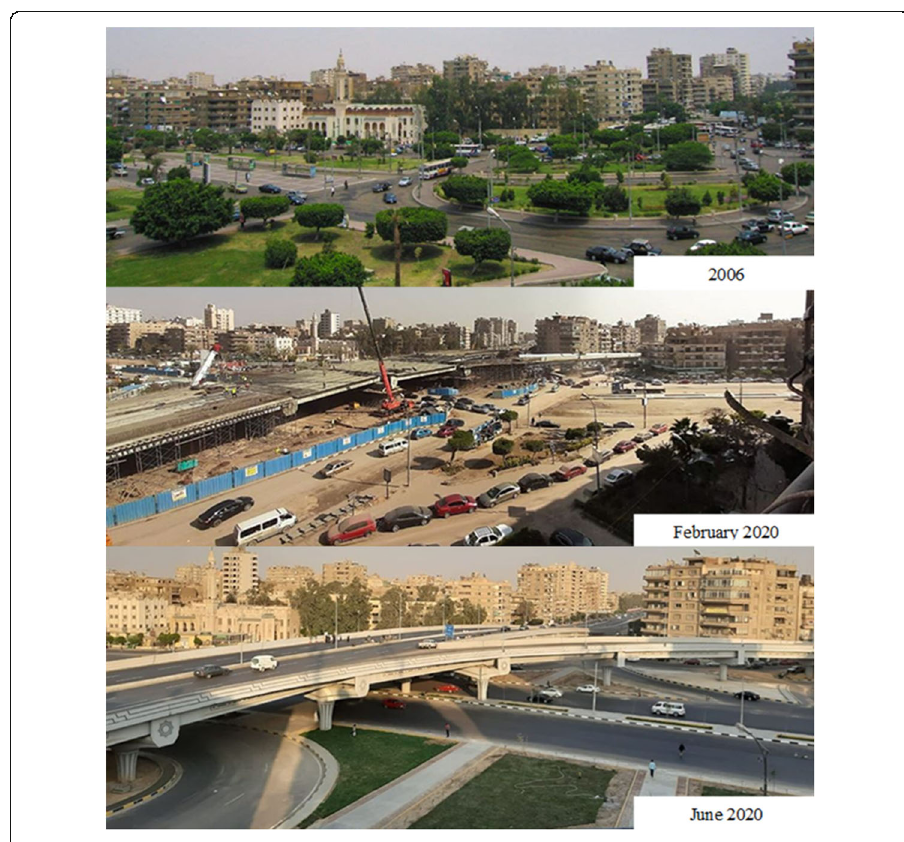
Fig. 11 al-Higaz Square, Heliopolis, Photos by Essam Arafa